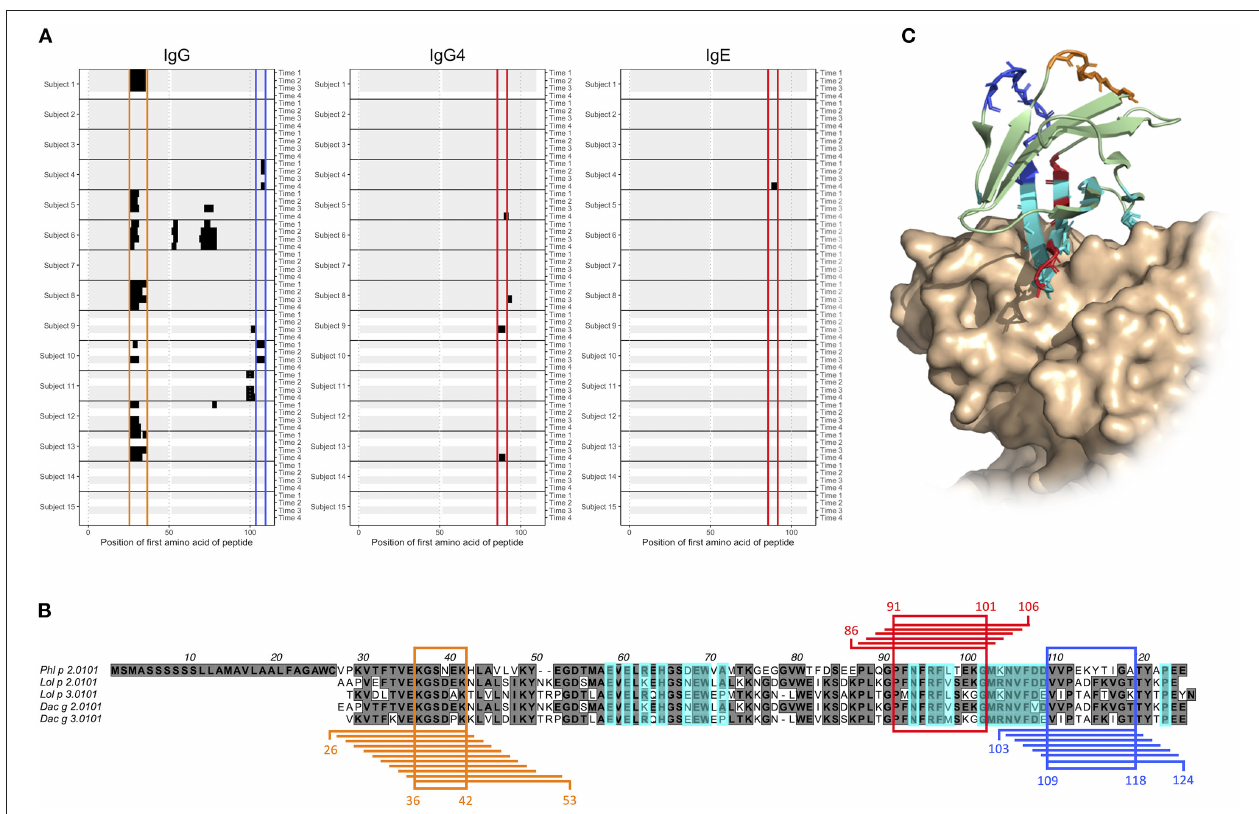
FIGURE 4 | Epitope D (red), E (orange), and F (blue) are found at Phl p 2.0101 and represented by peptides starting with amino acid 86–91, 26–36, and 103–109, respectively. (A) Phl p 2.0101 linear epitope binding pattern of IgG, IgG4, and IgE in serum samples of allergic individuals collected at start of AIT treatment (time 1), and 8 weeks (time 2), 1 year (time 3), and 3 years later (time 4). Epitope D (red), E (orange), and F (blue) have been marked. (B) Alignment of group 2 grass pollen allergens, with peptides representing epitope D (red), E (orange), and F (blue), and the common amino acid of all peptides in an epitope highlighted. A previously described ( 30) discontinuous epitope is also marked (cyan). (C) Crystal structure (PDB id 2VXQ) of Phl p 2.0101 with epitope D (red), E (orange), and F (blue) marked together with a previously described ( 30) discontinuous epitope (cyan), known to be recognized by stereotyped IgE seen in many allergic individuals